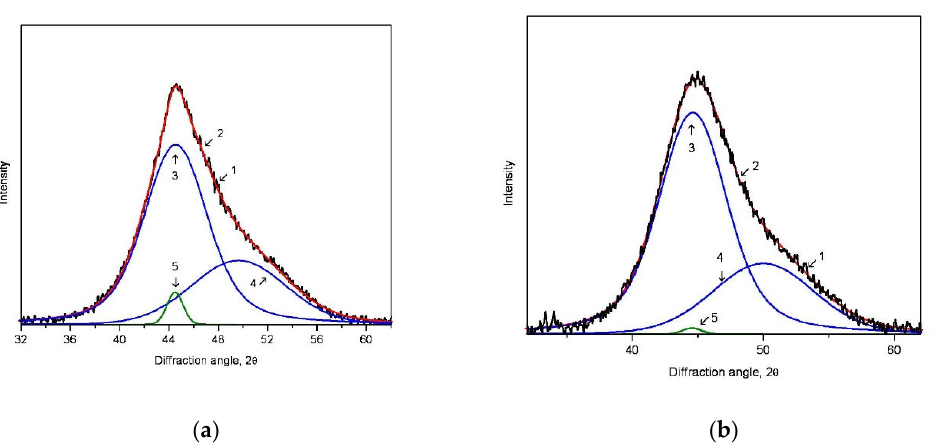
Figure 19. An initial part of the X ‐ ray diffraction pattern of Al88Ni6Y6 sample after deformation ( a ) and after deformation plus cryogenic cycling ( b ): (1) experimental spectrum, (3,4) diffuse reflections corresponding to 2 amorphous phases, (5) (111) Al nanocrystal reflection, (2) sum of 3–6 lines [reproduced from Mater. Let. 2019, 240, 159 with permission from Elsevier, 2020] [146].